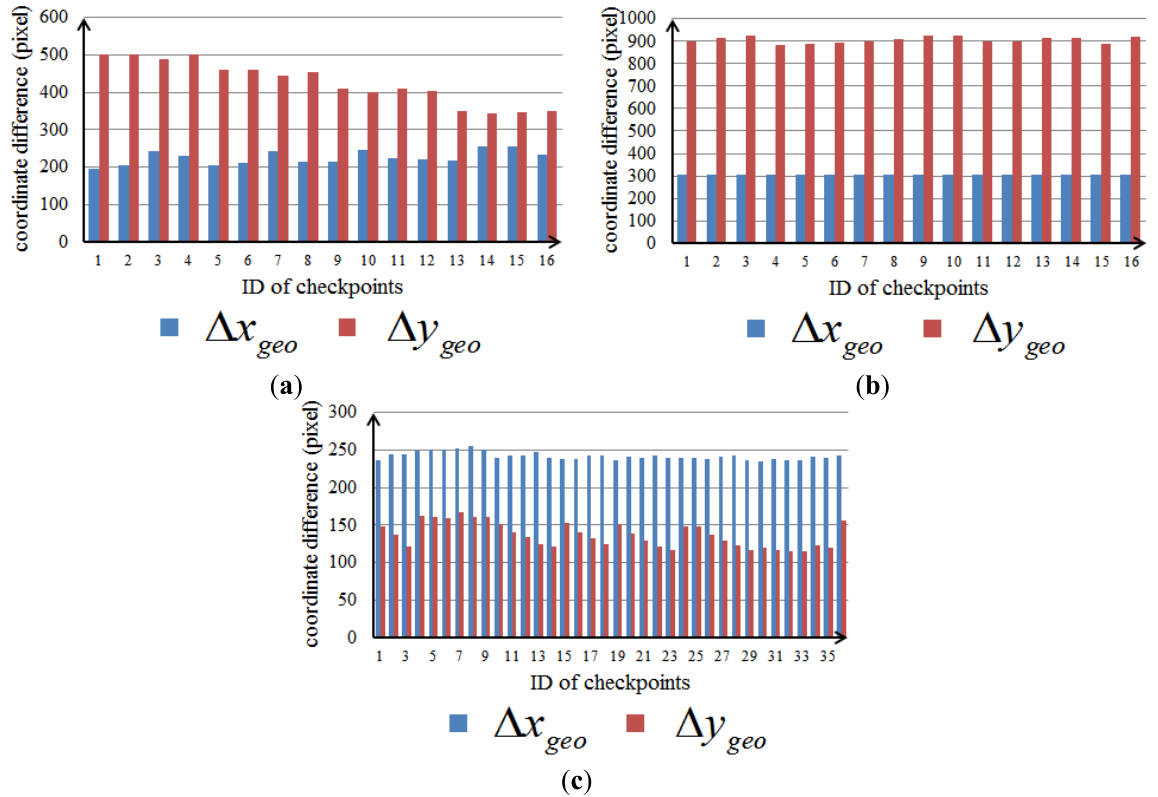
Figure 3. Coordinate difference between observed values of checkpoints. For ( a , b ) Datasets 1 and 2, 16 pairs of checkpoints are measured; and for ( c ) Dataset 3, the scale of the image is larger and 36 pairs of checkpoints are measured.